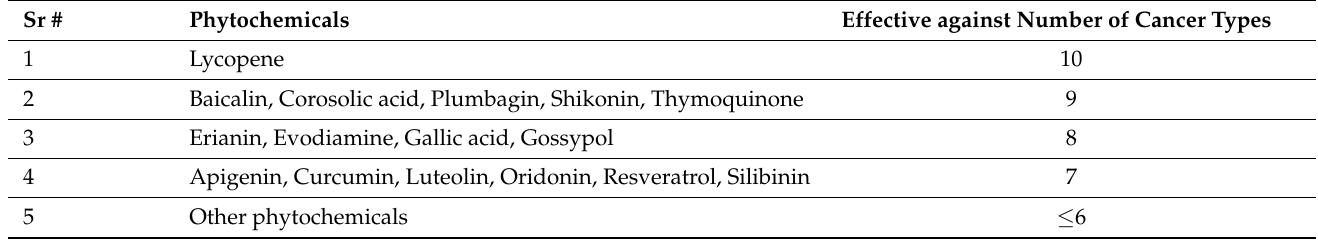
Table 4. Phytochemicals with activity against different number of cancer